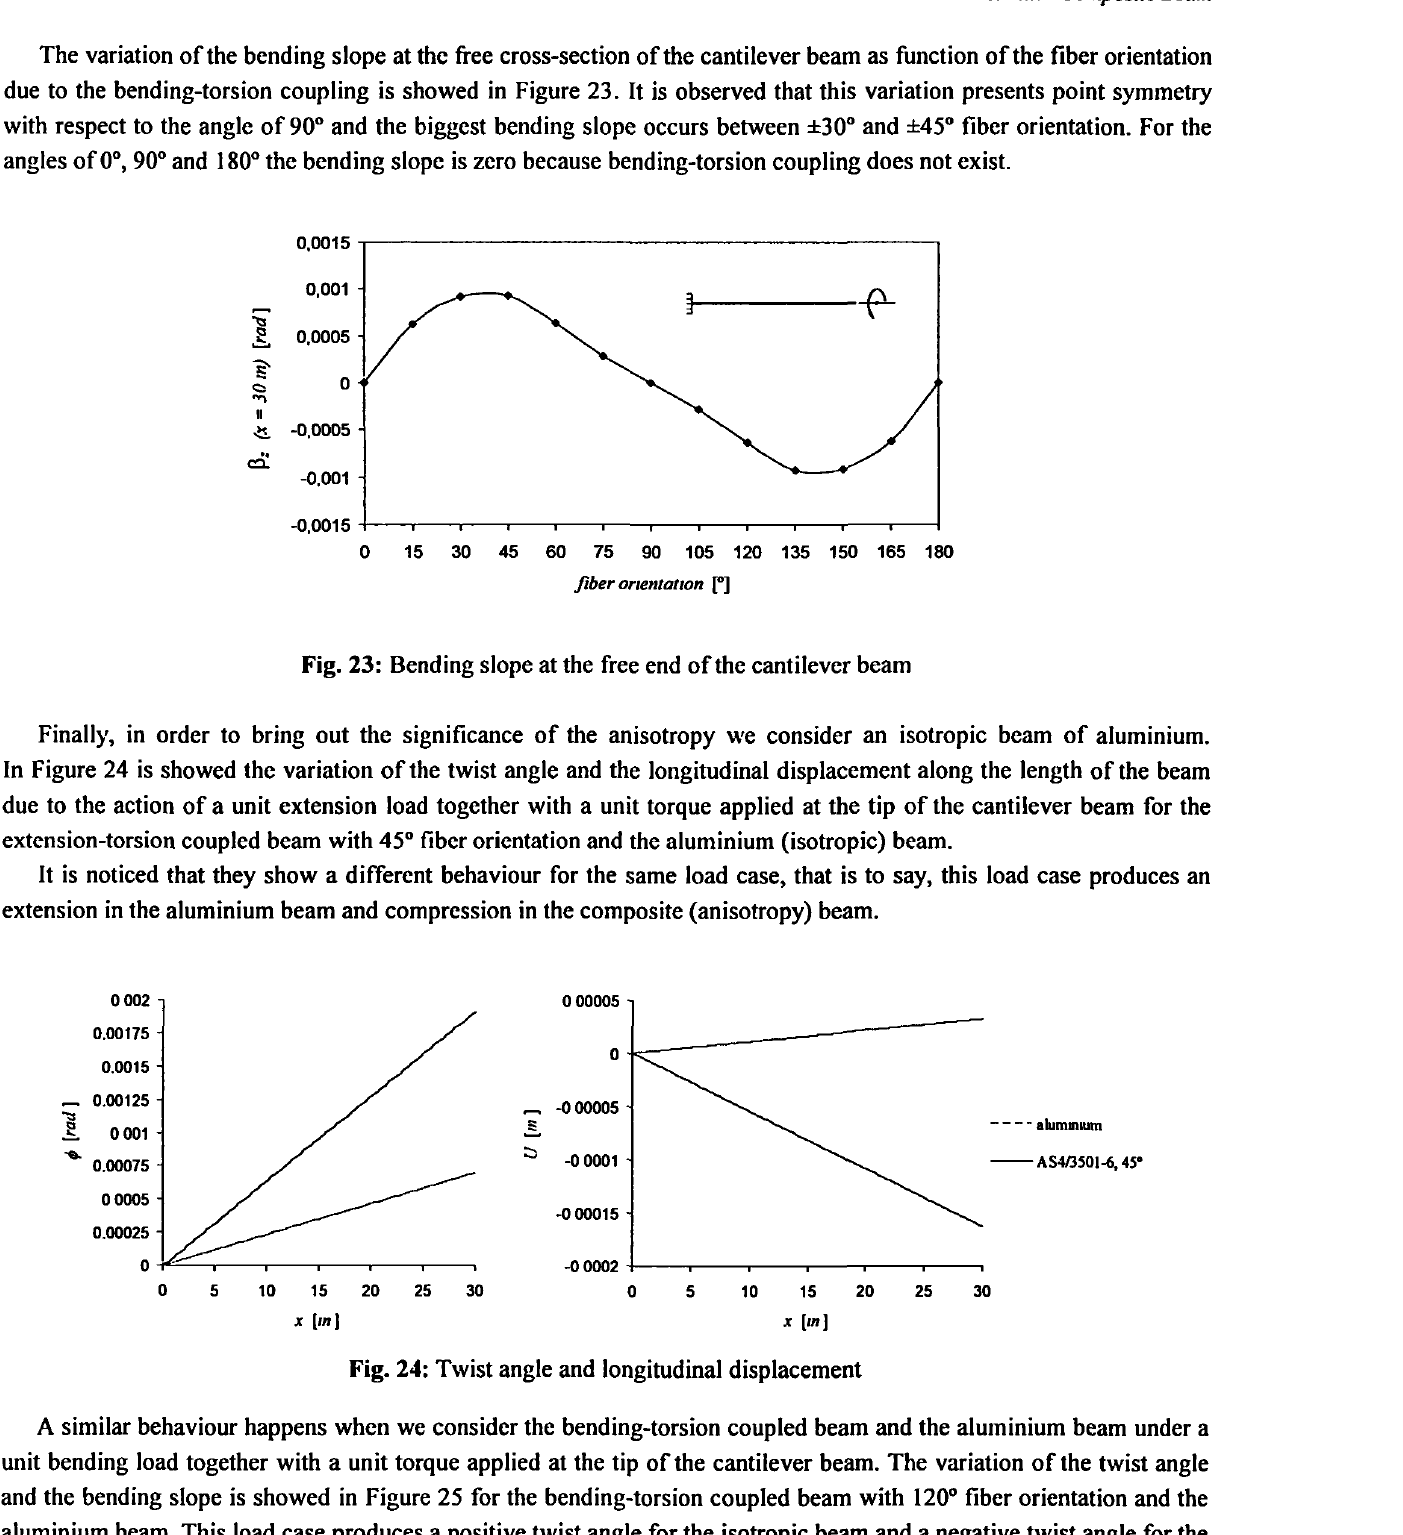
Fig. 24: Twist angle and longitudinal